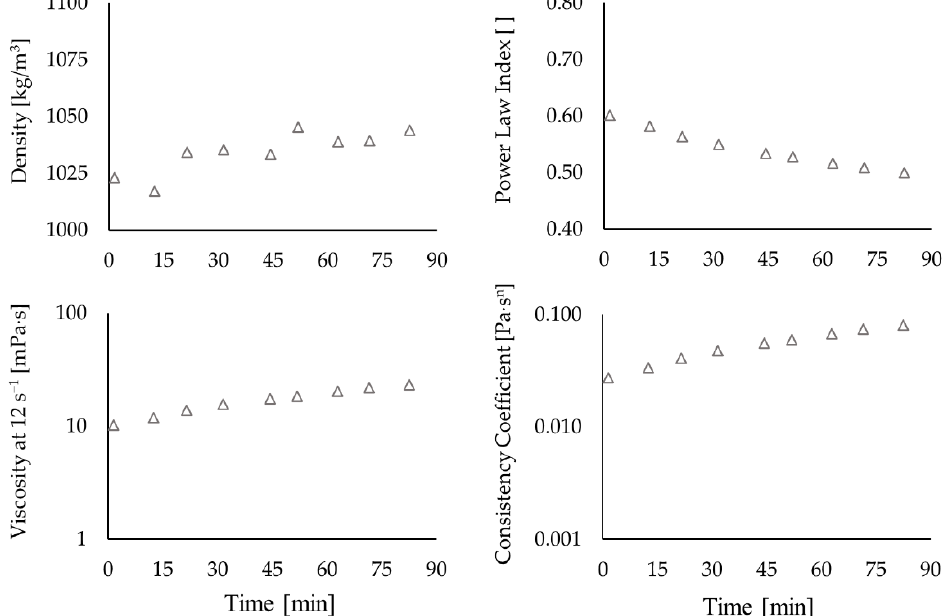
Figure A3. Evolution of the rheological parameters and density for the abiotic continuous system.